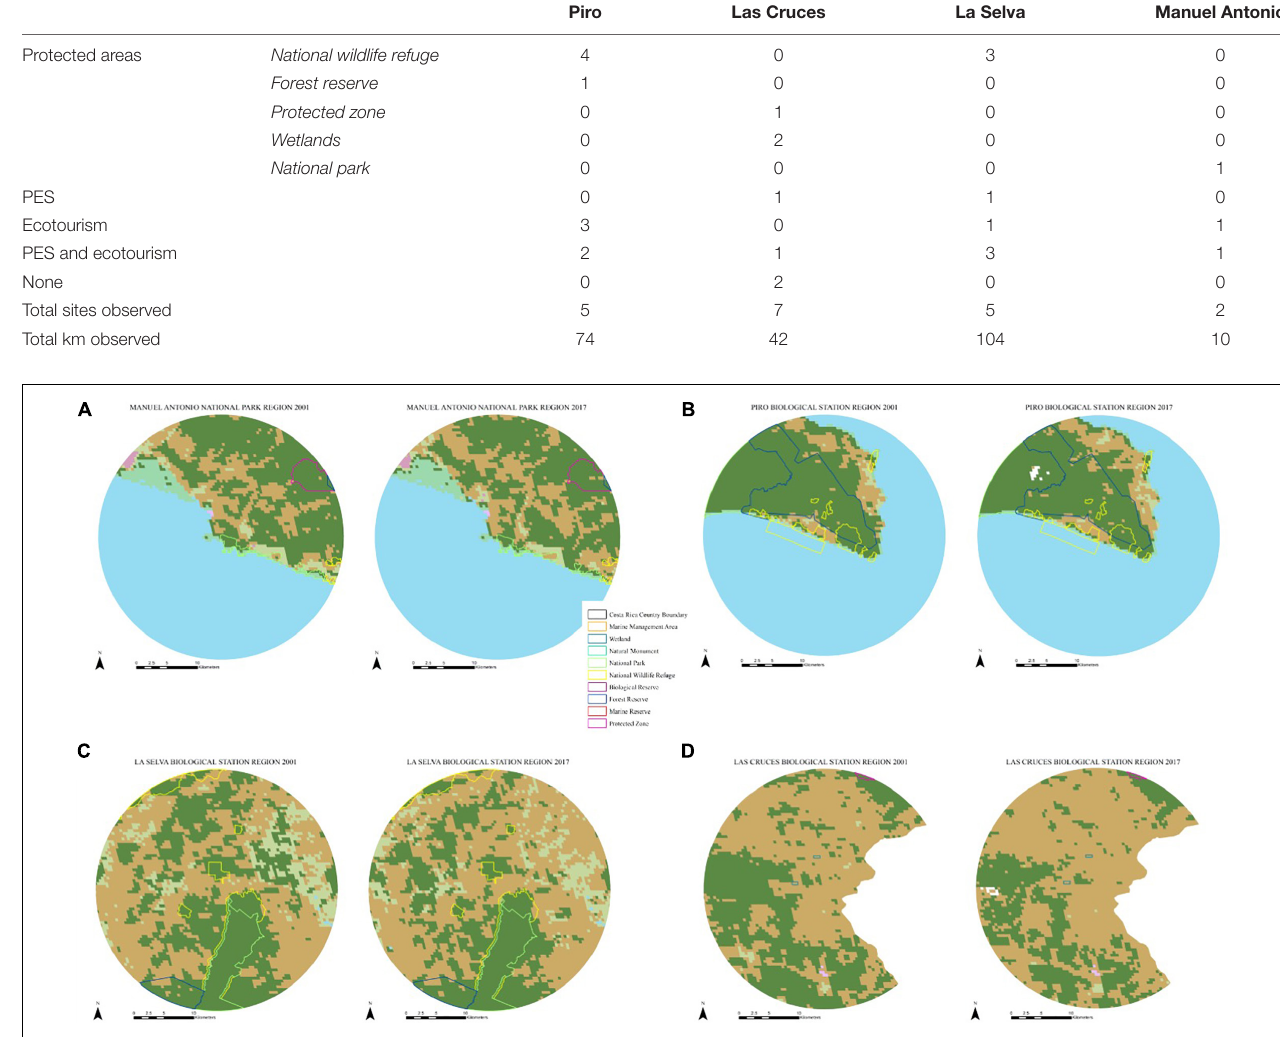
TABLE 4 | Sites surveyed for primates across four regions of Costa Rica by the type of conservation strategy or federal protection status in which the forest was enrolled. Piro Las Cruces La Selva Manuel Antonio